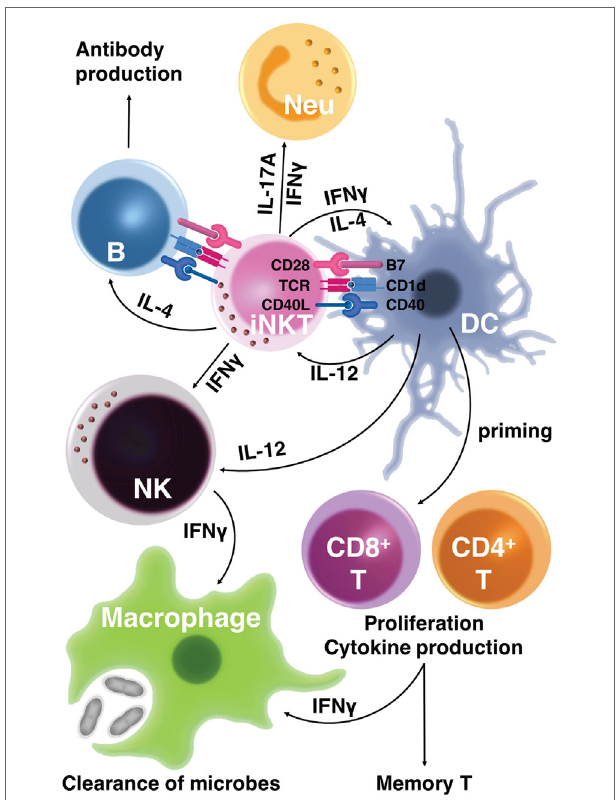
FiGURe 1 | Activation of CD1d-restricted invariant natural killer T ( i NKT) cells augments both innate and acquired immunity to control microbial infection. The T-cell receptor (TCR) of i NKT cells recognizes glycolipid antigens presented by CD1d on antigen-presenting cells (APCs). In response, activated i NKT cells produce cytokines, including interferon- γ (IFN γ ), interleukin-4 (IL-4), and IL-17A, that stimulate innate immune responses such as neutrophil (Neu) recruitment. Glycolipid-activated i NKT cells also express CD40 ligand (CD40L), which promotes APC maturation. i NKT cells provide cognate help to B cells to promote antibody production when glycolipid- conjugated antigens are presented by B cells. Through cytokine release and CD40L–CD40 interaction, i NKT cells stimulate dendritic cells (DCs), triggering DC production of cytokines such as IL-12. These DC-derived cytokines stimulate IFN γ production by i NKT cells, which in turn enhances microbial clearance by stimulating macrophages. Activated i NKT cells also induce maturation of DCs that prime IFN γ -producing effector CD4T and CD8T cells, resulting in the clearance of microbes. The mature DCs induced by activated i NKT cells enhance the differentiation not only of effector T cells but also of memory T cells, conferring long-term protection against microbial